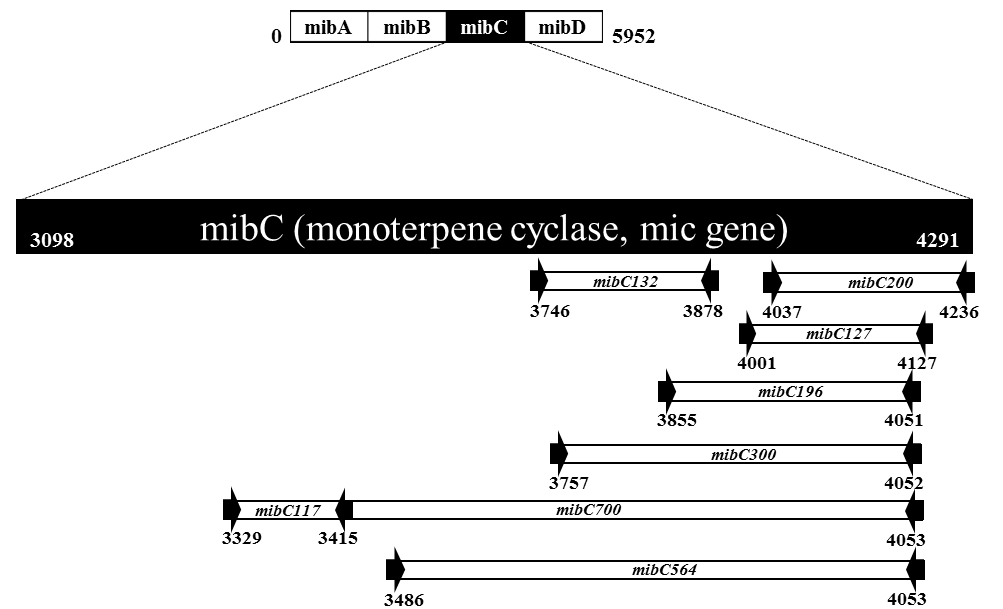
Figure 1. The 2-Methylisoborneol (2-MIB) synthesis-associated operon and positions of the designed primers on mibC (Adapted from Chiu et al., 2016). The sequences of mibC from the GenBank database, including Pseudanabaena sp. dqh15, were aligned, and the homologous region of mibC was selected for primer targeting. The arrows represent the directions of the primers, and the numbers in the primer names indicate the expected sizes (base pairs).